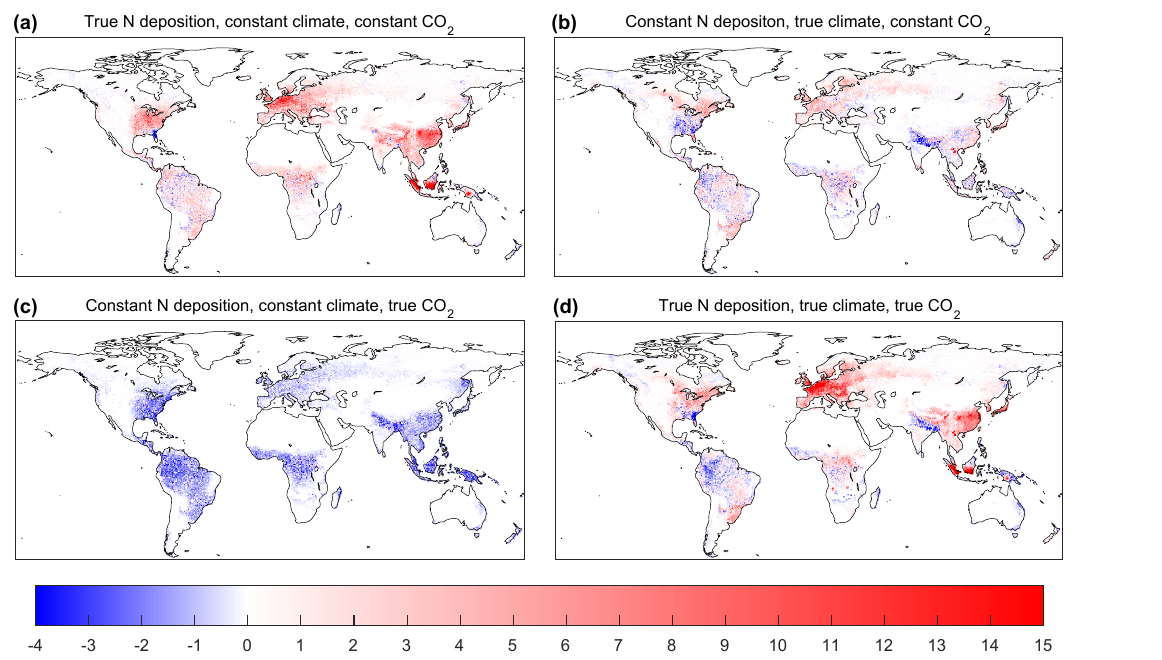
Figure 11. Mineral N leaching difference (kgNha − 1 yr − 1 ) relative to the control simulation ( − Ndep − clim − CO 2 ) for the single-factor runs and the true historical simulation. For readability, the colour axis has been cut off at the 1 and 99% quantile over all graphs.